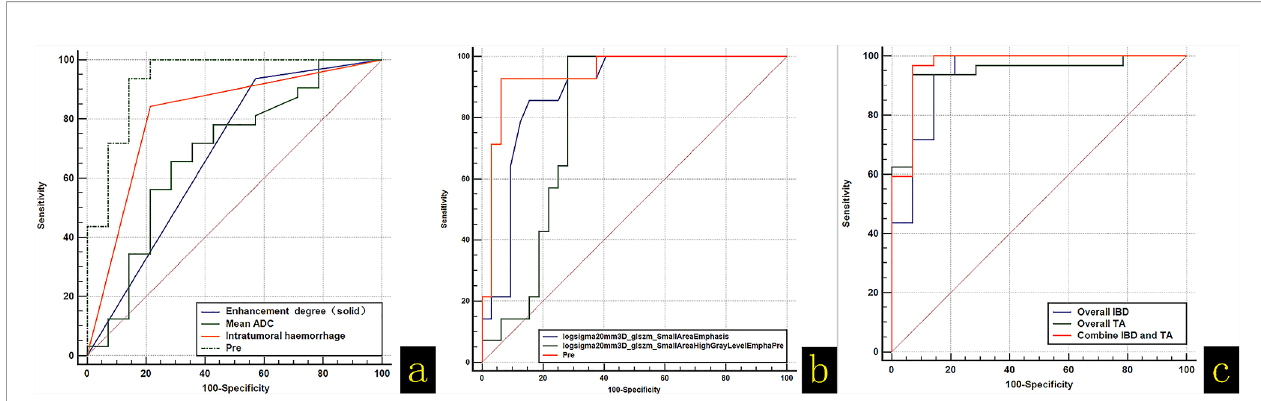
FIGURE 4 | (A) (ROC) curve analysis of the diagnostic abilities of apparent diffusion coef fi cient values (average), enhancement degree, presence of intratumoral hemorrhage, and the prediction models. (B) ROC curve analysis of Log-sigma-2-0mm-3D_glszm_SmallAreaEmphasis,